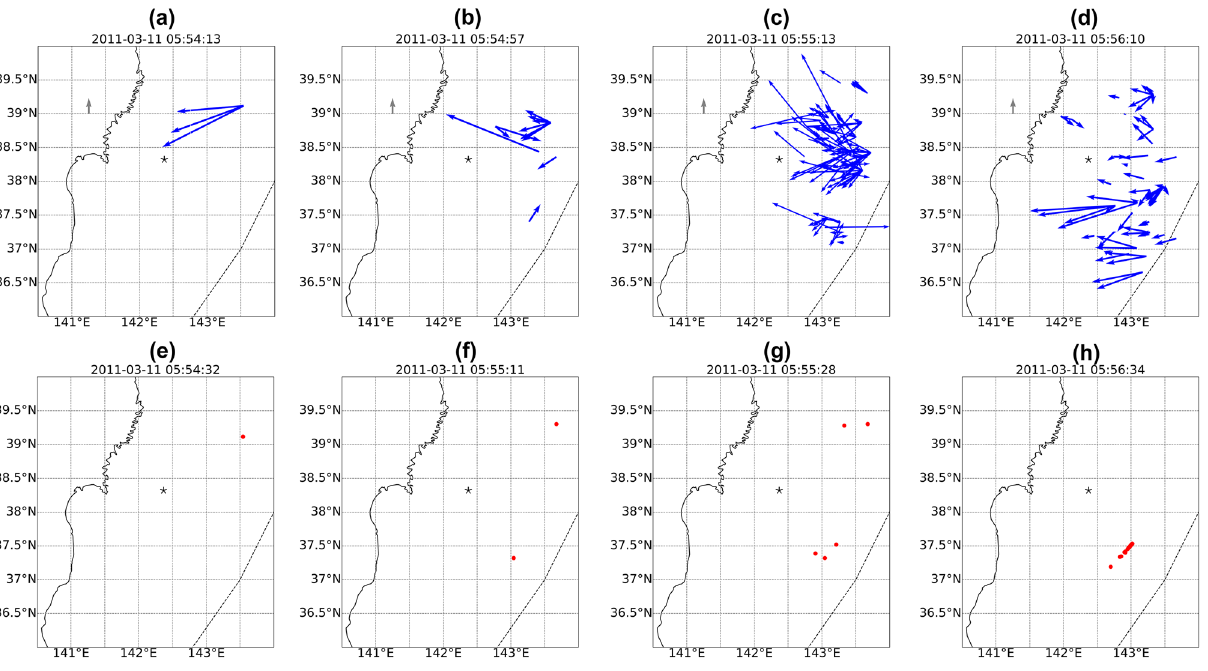
Figure 6. ( a-d) CTID velocity field calculated from the first CTID detected by GPS satellite PRN 26 after the Tohoku earthquake. The dotted curve shows the position of the Japan Trench, black star depicts the epicenter. The gray arrow corresponds to 1.1 km/s; (e–h) localization of the seismic source as estimated from the first velocity vectors shown on panels (a–d).